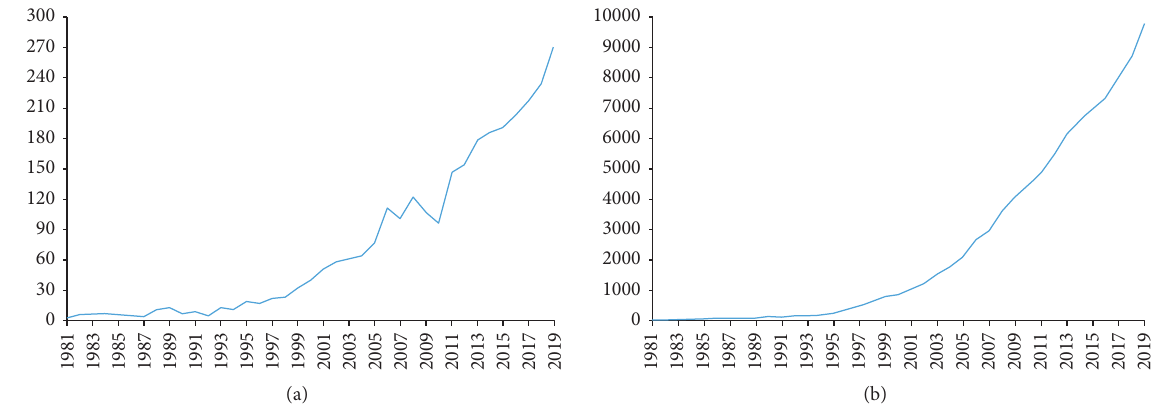
Figure 1: Number of publications and citations. (a) The number of annual publications on pain and inflammation research from 1981 to 2019. (b) The number of annual citations on pain and inflammation research from 1981 to